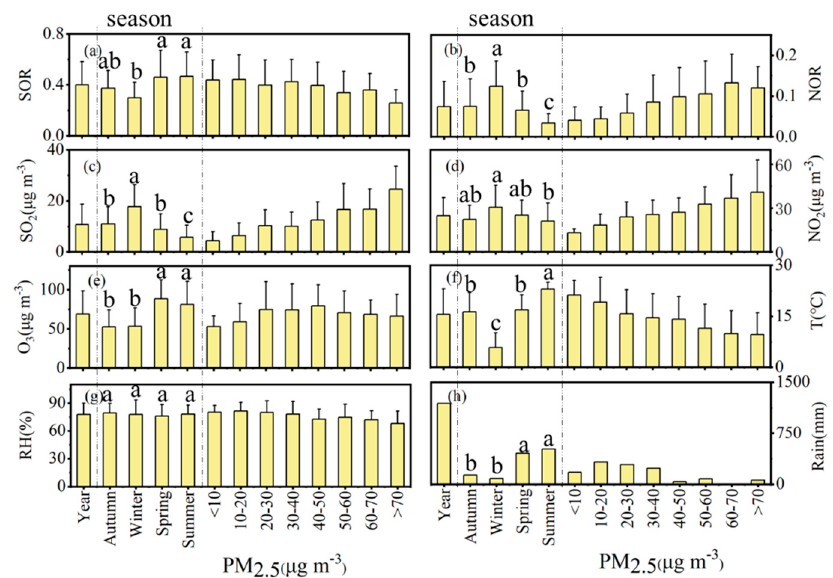
Figure 4. Mean ± SD values (except the precipitation) of ( a ) sulfur oxidation ratio (SOR), ( b ) nitrogen oxidation ratio (NOR), ( c ) SO 2 , ( d ) NO 2 , ( e ) O 3 , ( f ) Temperature, ( g ) The relative humidity (RH), ( h ) The total Precipitation for sampling days, different seasons and the different gradients of PM2.5 concentrations in Guiyang (the different lower cases letters above the boxes indicated that there are significant statistical differences ( p < 0.05) among seasons).